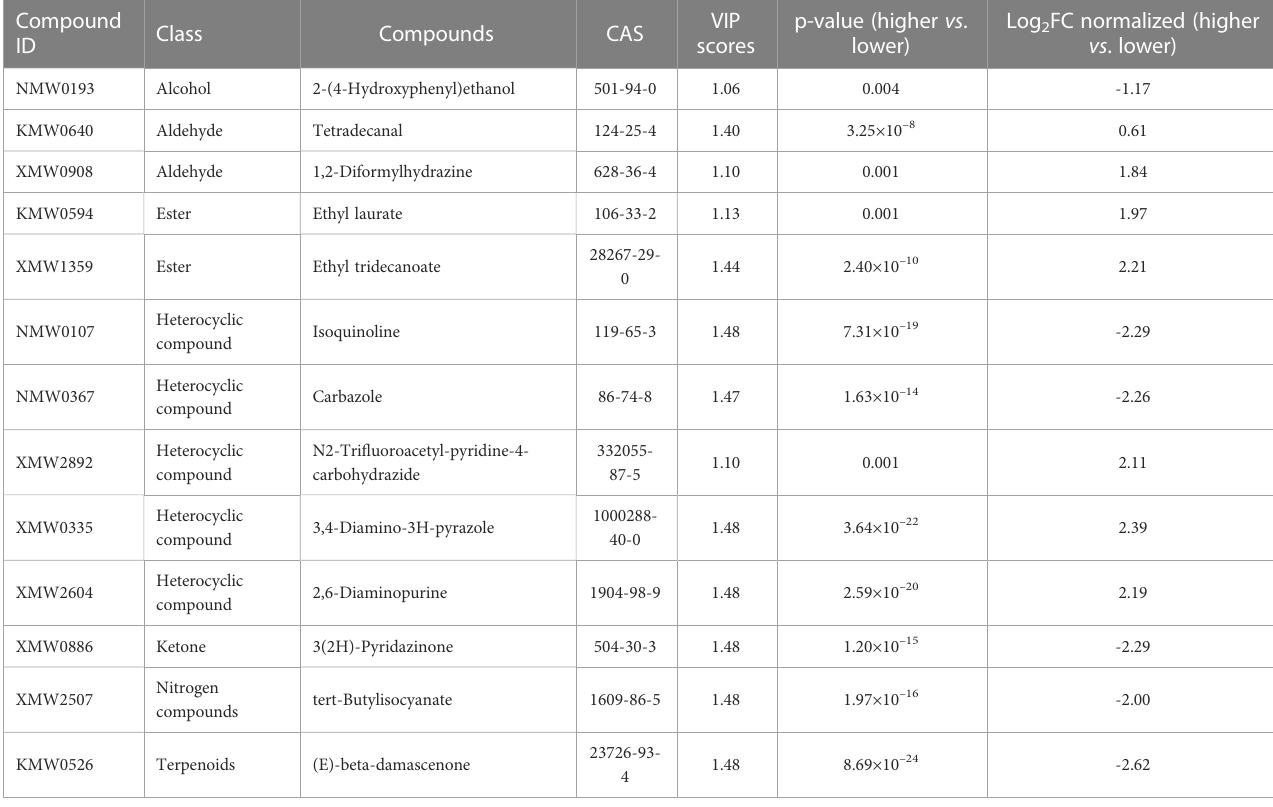
TABLE 2 Discriminating volatile compounds identi fi ed by VIP analysis and p-value together with fold-change cut off > 1.5 or < 0.5.